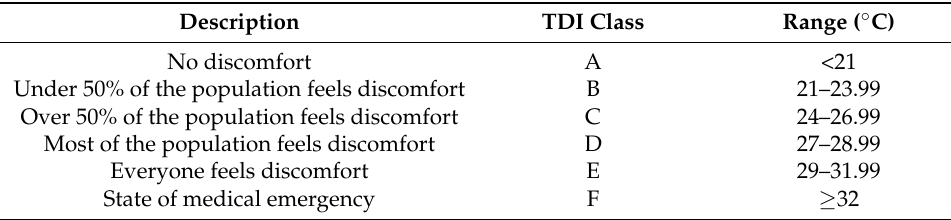
Table 1. Description, classes and ranges of Thom’s discomfort index (TDI) [26].